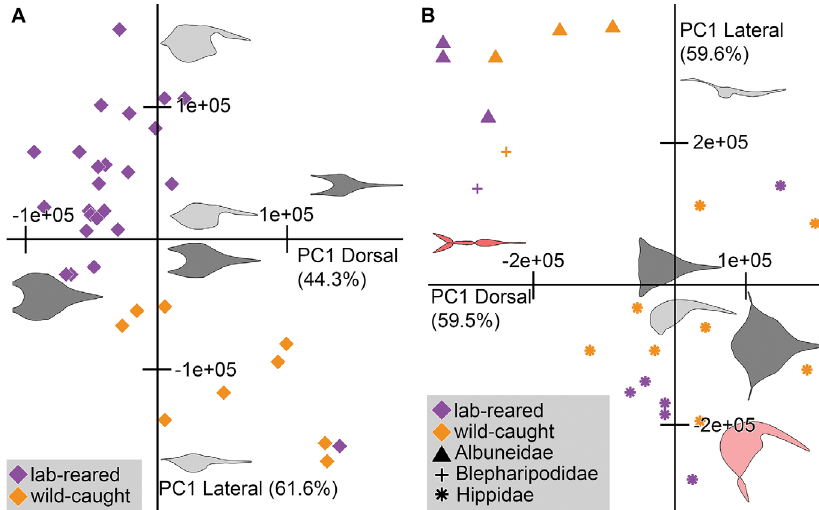
Figure 4. Plot of principal components from the PCA on the SHAPE analysis of shield outlines of Galatheidae and Hippoidea. A: PC1 of the dorsal analysis plotted against PC1 of the lateral analysis of Galatheidae. Shapes included are from graphical component loadings and depict the mean shape of the principal component and +/-2 standard deviations of the mean shape. Color coding: dark grey: shapes of PC1 from the dorsal analysis; light grey: shapes of PC1 of the lateral analysis. B : PC1 of the dorsal analysis plotted against PC1 of the lateral analysis of Hippoidea. Shapes included are from graphical component loadings and depict the mean shape of the principal component and +/-2 standard deviations of the mean shape. Color coding: dark grey: shapes of PC1 from the dorsal analysis; light grey: shapes of PC1 of the lateral analysis; dark red: impossible shapes of PC1 from the dorsal analysis; light red: impossible shapes of PC1 of the lateral